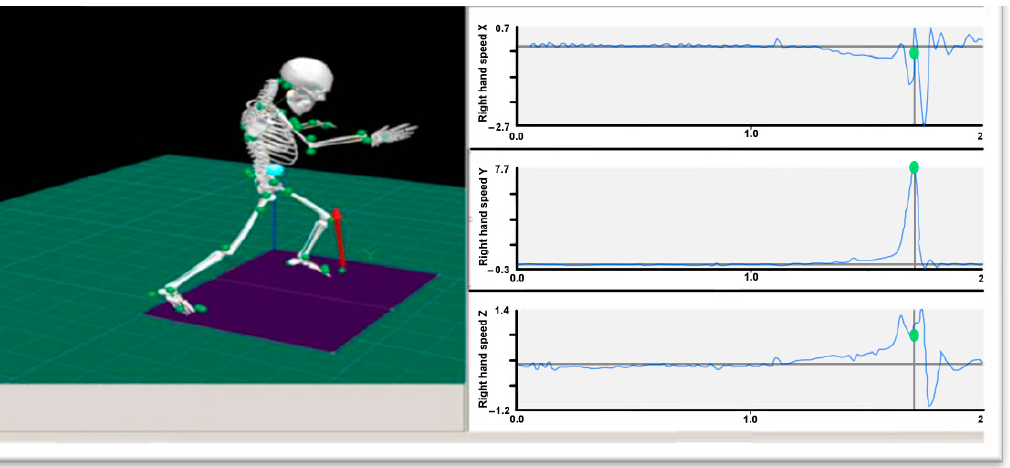
Figure 5. Vicon 3DMotion Resolution Interface diagram.